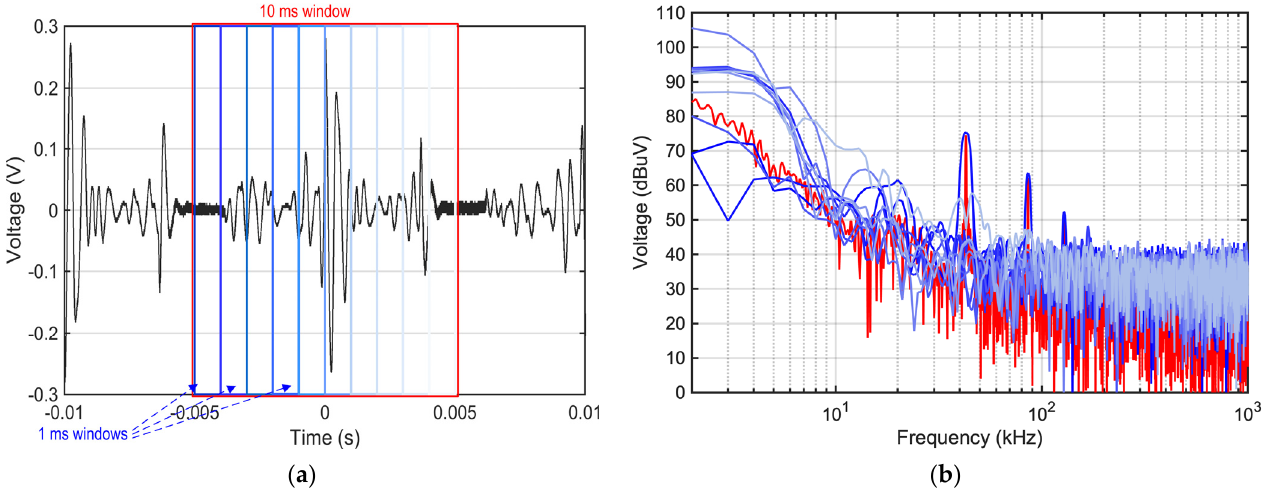
Figure 6. ( a ) Arrangement of STFT windows for long (red) and short (blue) window choices ( T = 10 ms and 1 ms, respectively) and ( b ) the resulting spectra. ( T = 10 ms and 1 ms, respectively) and ( b ) the resulting